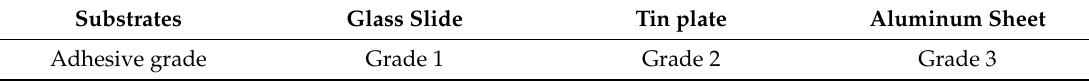
Table 7. The adhesive properties of the coatings on various